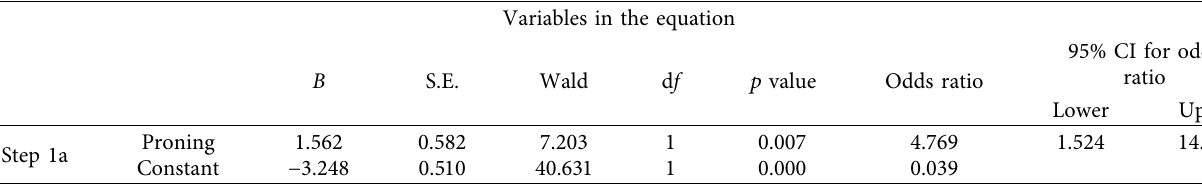
Table 6: Proning and occurrence of stroke.